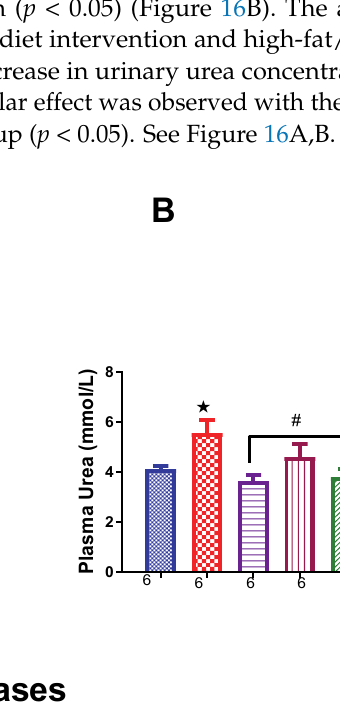
urinary urea concentration ( p < 0.05) (Figure 16B). The administration of the rhenium